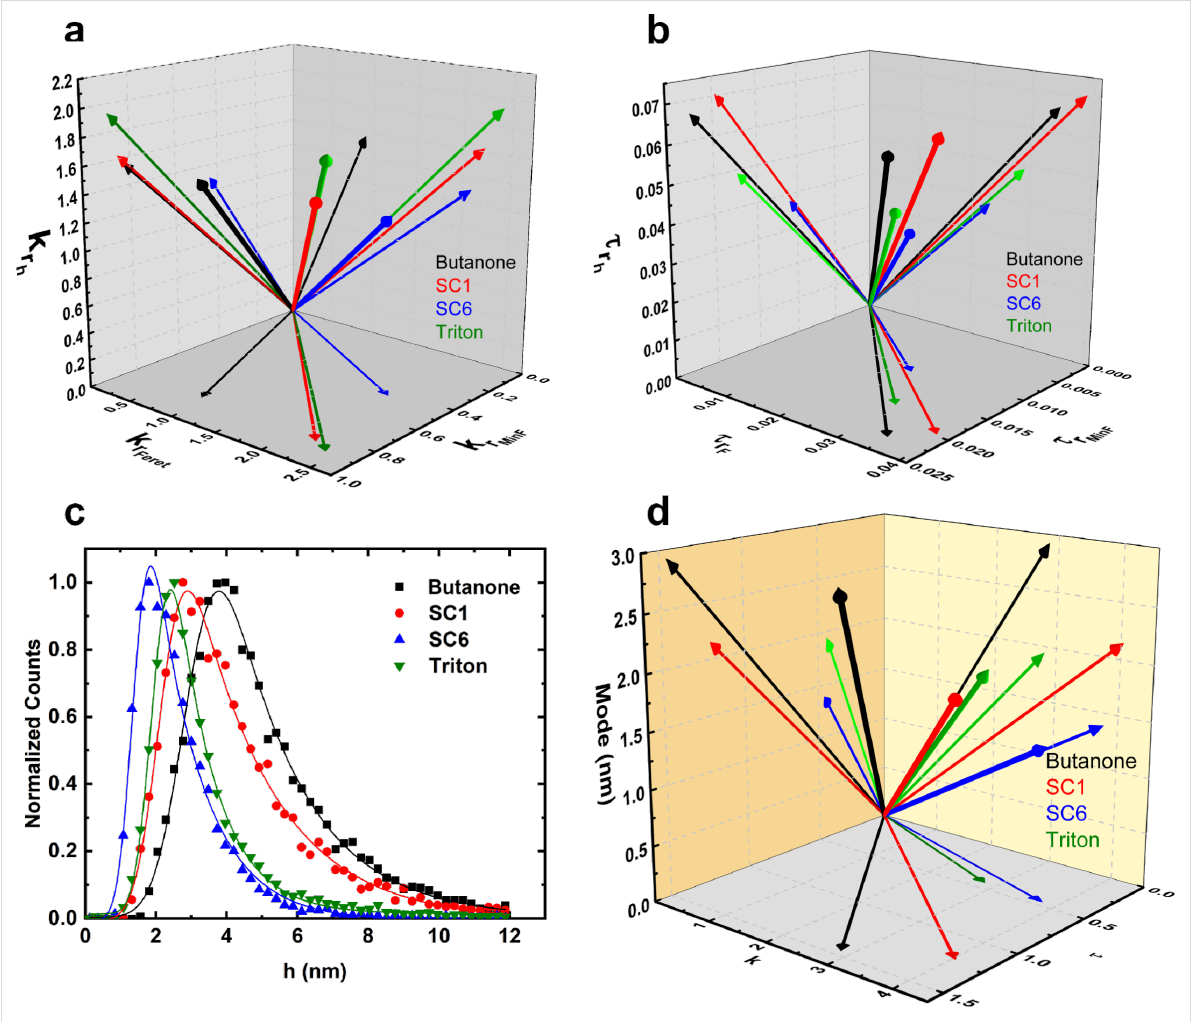
Figure 4: Shape vectors k and τ for each sample and normalized distribution of flake thickness. (a) Shape vectors k (each dimension is related to the asymmetry of the distribution of the natural logarithm of one of the three dimensionless shape parameters r h , r Feret , and r MinF ). (b) Trimness shape vectors τ for all four samples. (c) Normalized histogram of the flake thickness h (black squares: butanone; red circles: sodium cholate at 1 mg/mL; blue upward triangles: sodium cholate at 6 mg/mL; green downward triangles: Triton-X100). (d) 3D vector plot of three parameters obtained from the EMG fit adjusted to the h data in (c): mode, k , and τ